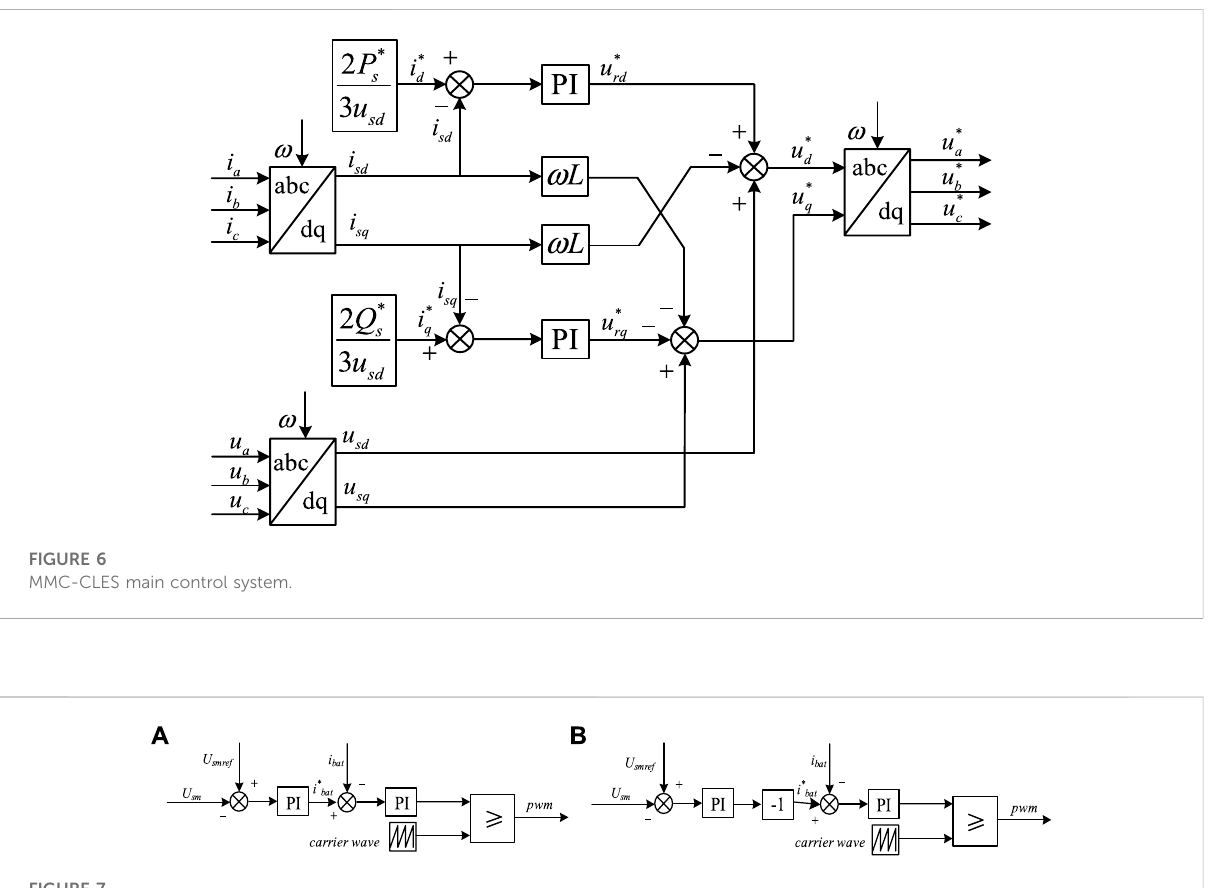
FIGURE 7 Bidirectional DC-DC control system. (A) shows the buck mode control chart. (B) shows the boost mode control